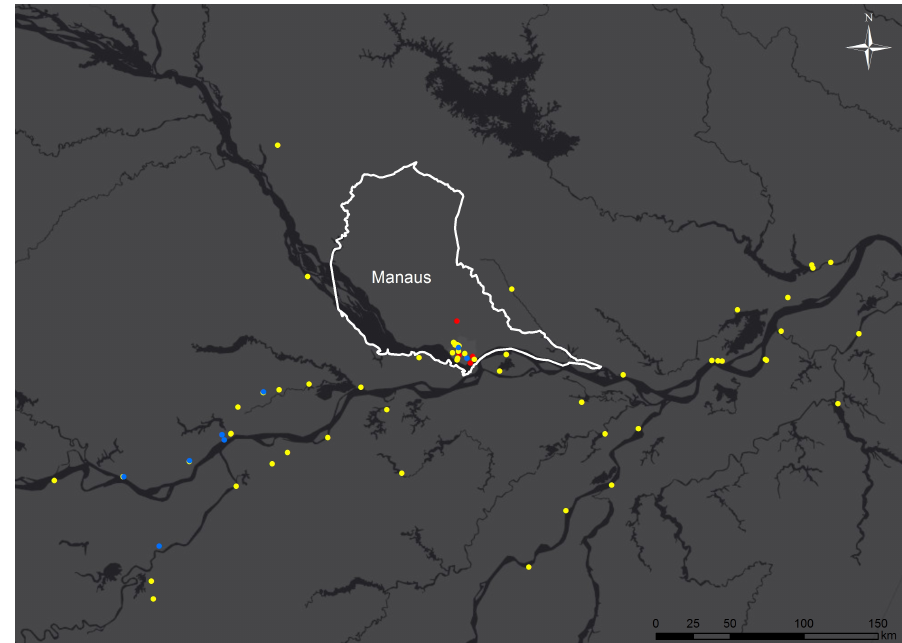
Figure 2. Spatial distribution of diesel (yellow), fuel oil (red) and natural gas (blue) TPPs on the study grid, and the border of Manaus